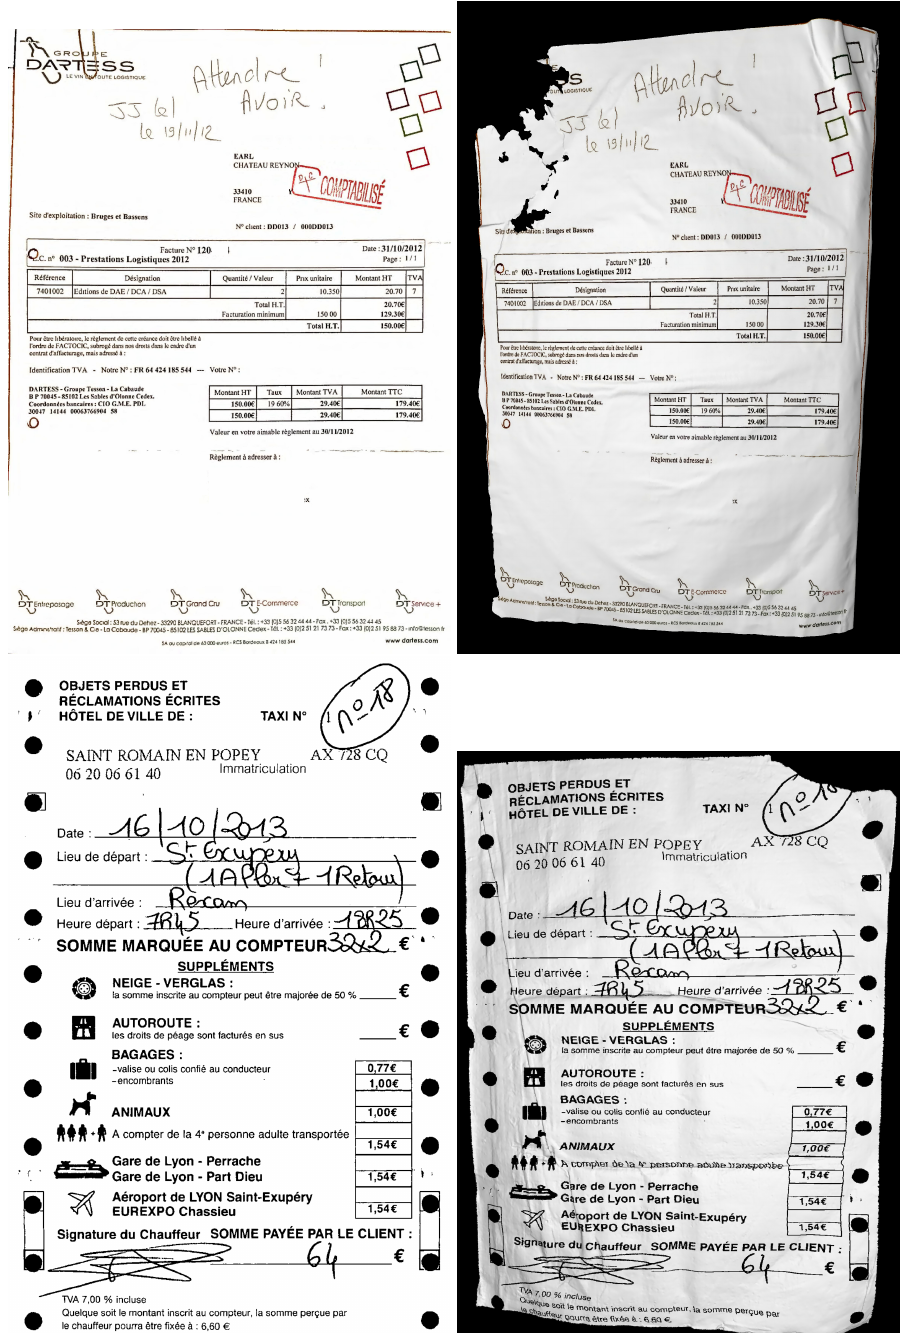
Figure 8. Examples of 3D deformations of a 2D receipt images. ( Left ) original images. ( Right ) degraded